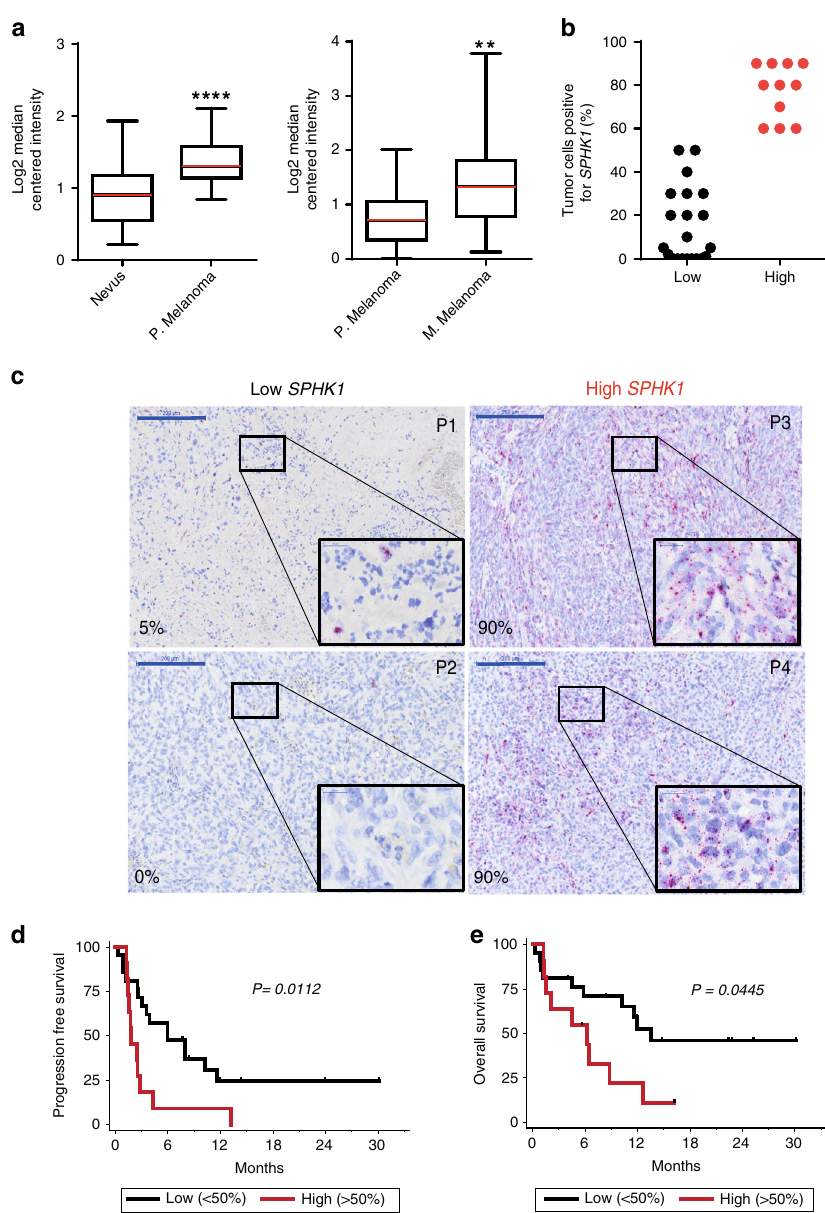
Fig. 1 SPHK1 expression inversely correlates with survival after ICI therapy. a SPHK1 expression in human nevi ( n = 17) compared to primary (P) melanoma ( n = 45), and in primary melanoma ( n = 25) compared to metastatic (M) melanoma ( n = 44) based on the Oncomine database. Data were compared using Mann – Whitney test. The bottom-most and topmost horizontal lines, the lower and upper hinges, and the middle line of the boxplots indicate the minimum and maximum values, the 25th and 75th percentiles, and the median, respectively. b Percentages of cancer cells positive for SPHK1 mRNA staining in metastatic melanoma tissues of 32 patients prior anti-PD-1 treatment (Low: ≤ 50% of tumor cells are positive (black points); High: > 50% of tumor cells are negative (red points)). c Representative mRNA staining of low and high SPHK1 expression. Skin (P1,P3) or lymph node (P2,P4) biopsies from patients (P). Percentages (%) indicate the proportion of cancer cells positive for SPHK1 mRNA staining. Large and small blue lines represent 200 and 20 μ m, respectively. d Progression-free survival and e overall survival curves of patients with >50% of melanoma cells positive for SPHK1 (red line; n = 11) or <50% (black line; n = 21). Survival times were calculated from the fi rst day of the cycle of anti-PD-1 post biopsy. Statistical signi fi cance was determined by log-rank